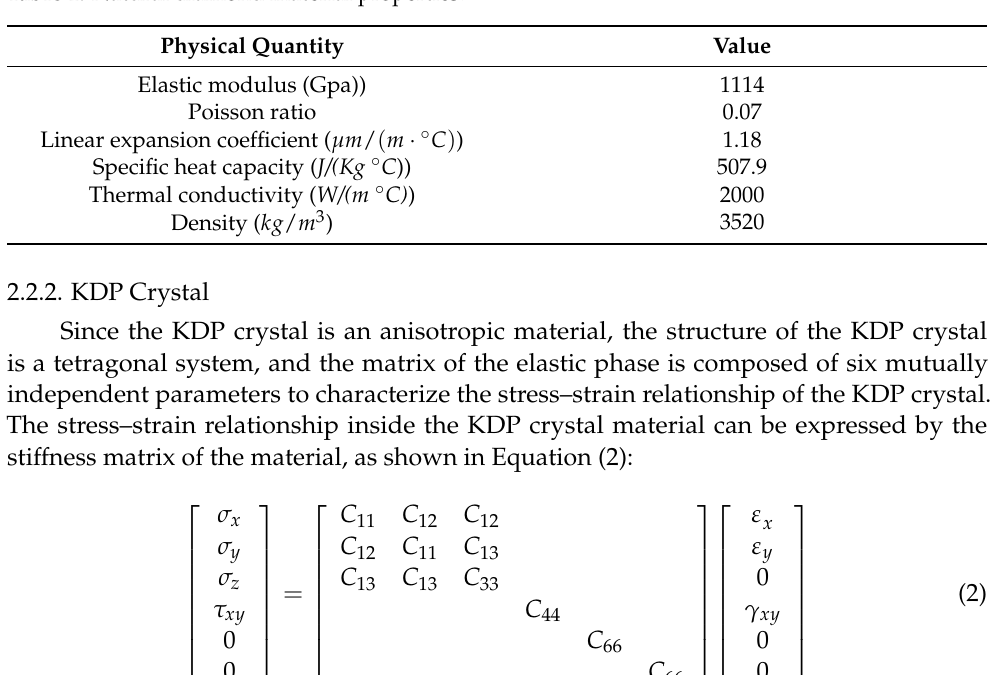
Table 1. Natural diamond material properties.